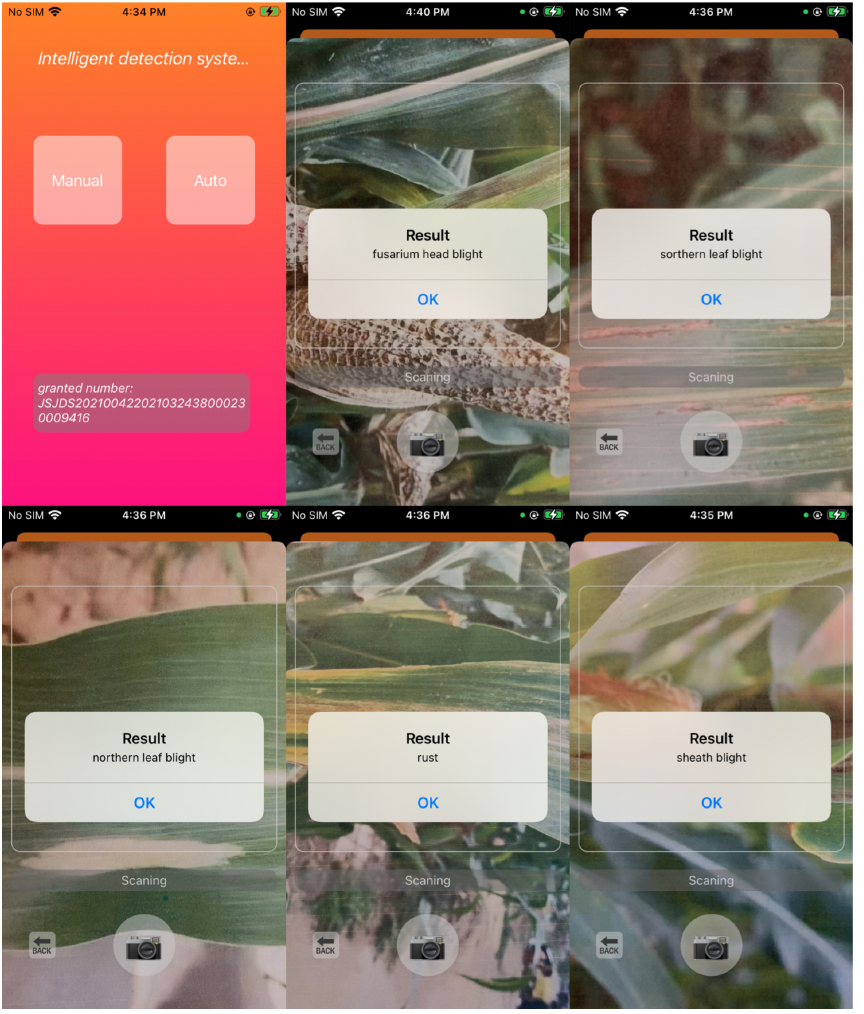
Figure 20. Screenshot of launch page and detection